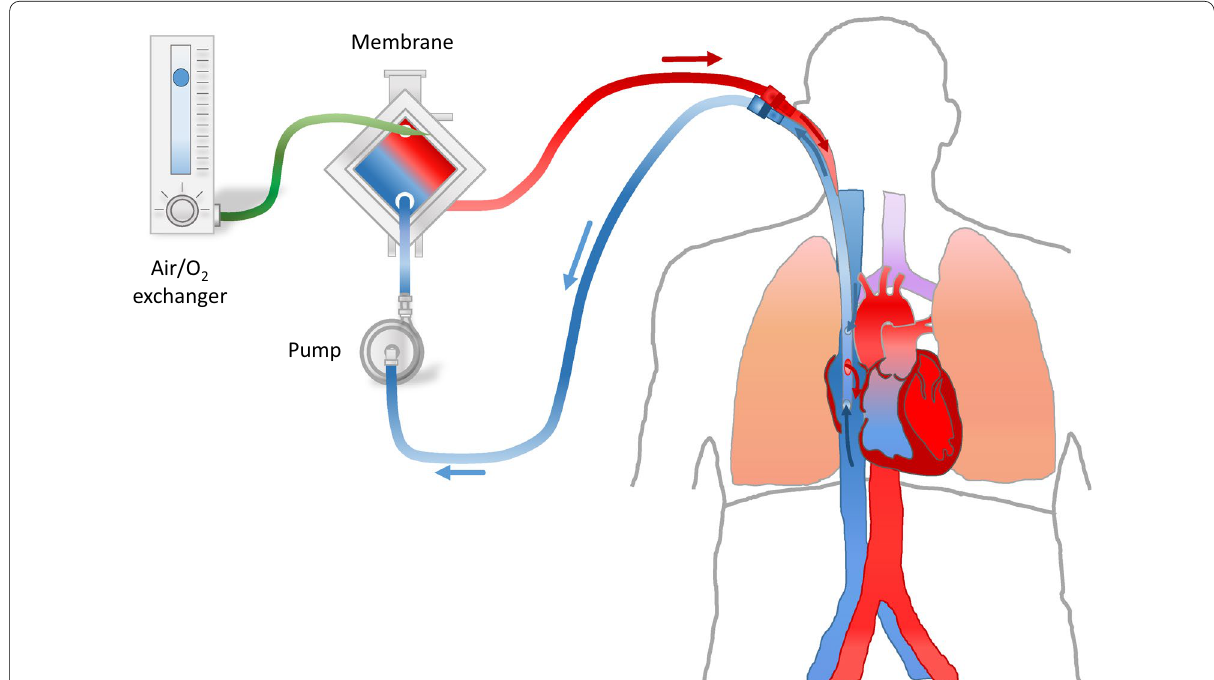
Fig. 2 Venovenous ECCO 2 R system with pump. ECCO 2 R: extracorporeal carbon dioxide